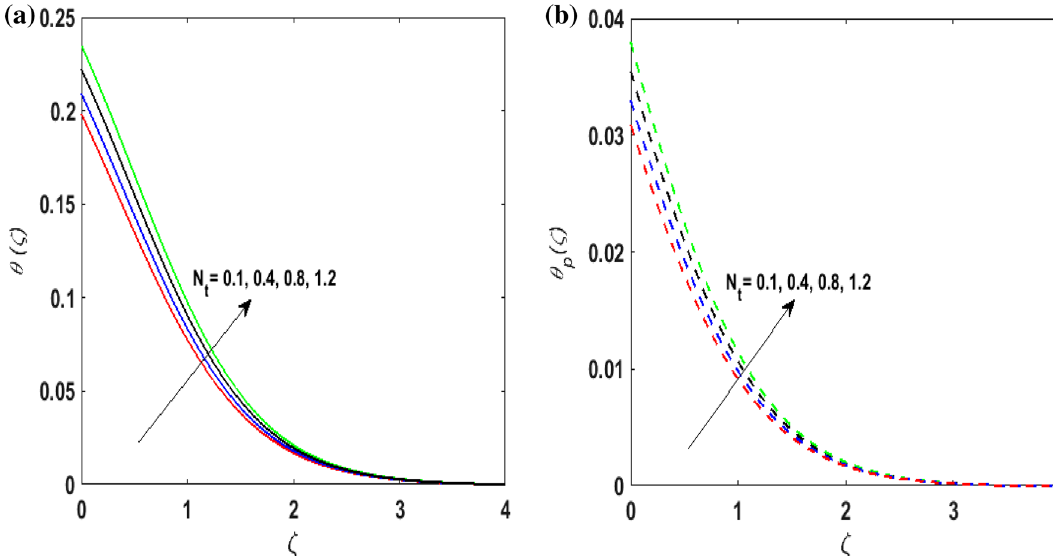
Figure 8. ( a ) θ(ζ) for various N t . ( b ) θ p (ζ) for various N t .